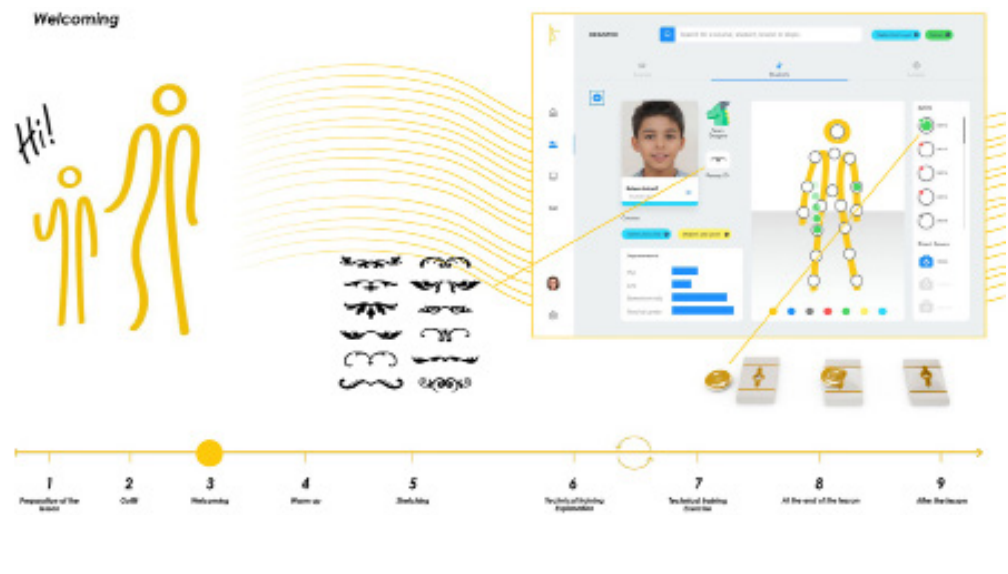
Fig. 15 Zambonini A., mock-up of the graphic interface of the PASSAY educational game: phase “welcoming”,